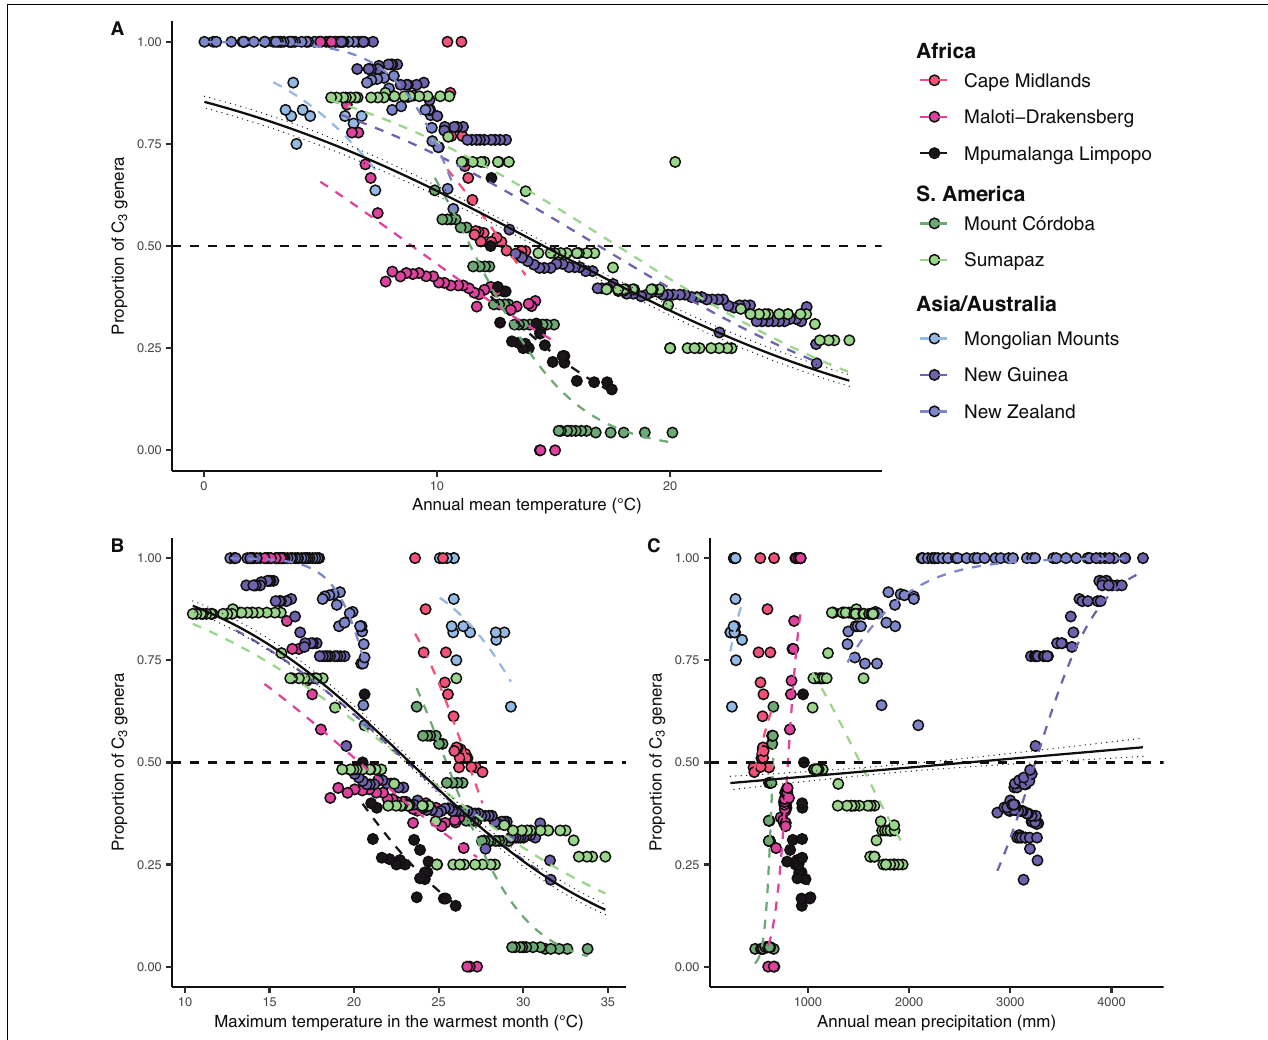
FIGURE 4 | The global relationship between the proportion of C 3 genera in each elevation interval and their respective maximum temperature in the warmest month and annual precipitation. (A) Annual mean temperature ( ◦ C) vs. the proportion of C 3 Poaceae genera in each elevation interval. (B) Maximum annual temperature ( ◦ C) vs. the proportion of C 3 Poaceae genera in each elevation interval. (C) Annual precipitation (mm) vs. the proportion of C 3 Poaceae genera in each elevation interval. Each point represents a 50 m elevation belt in each mountain (represented by the colors on the legend) in each continent/region. Dashed colored lines represent individual mountains fitted logit link function with a binomial distribution (with events/trials structure) for the number of C 3 and C 4 genera found in each site. The continuous black lines represent the global fitted logit function for each variable with 95% confidence interval. The horizontal dashed black line represents the 50% of C 3 threshold, proposed here as the